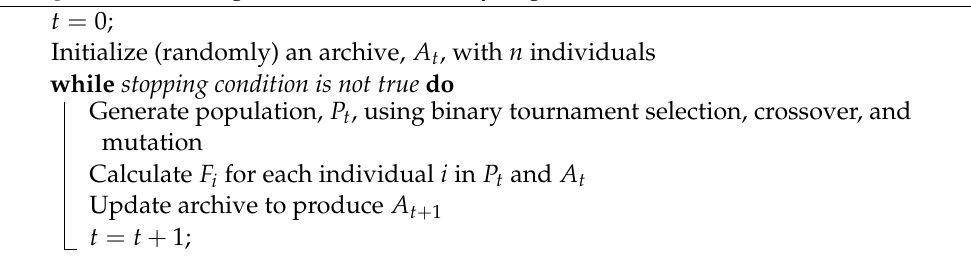
Algorithm 7: Strength Pareto Evolutionary Algorithm